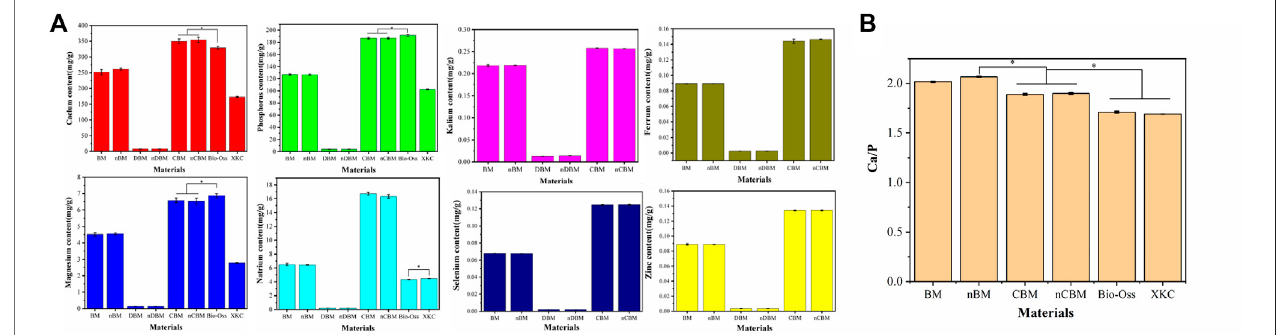
FIGURE 5 | Mineral content (A) and Ca/P ratio (B) of different bone powders, * p < 0.05.